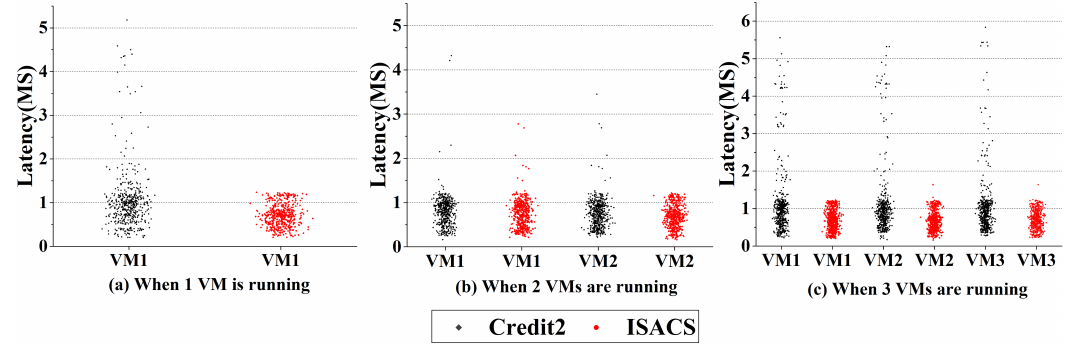
Figure 7. Network latency distribution between 25% and 75% for the result of 1000 experiments per experiment rounds according to the VM configuration in a hybrid environment. Table 3. Average of network latency according to the VM configuration based on Figure